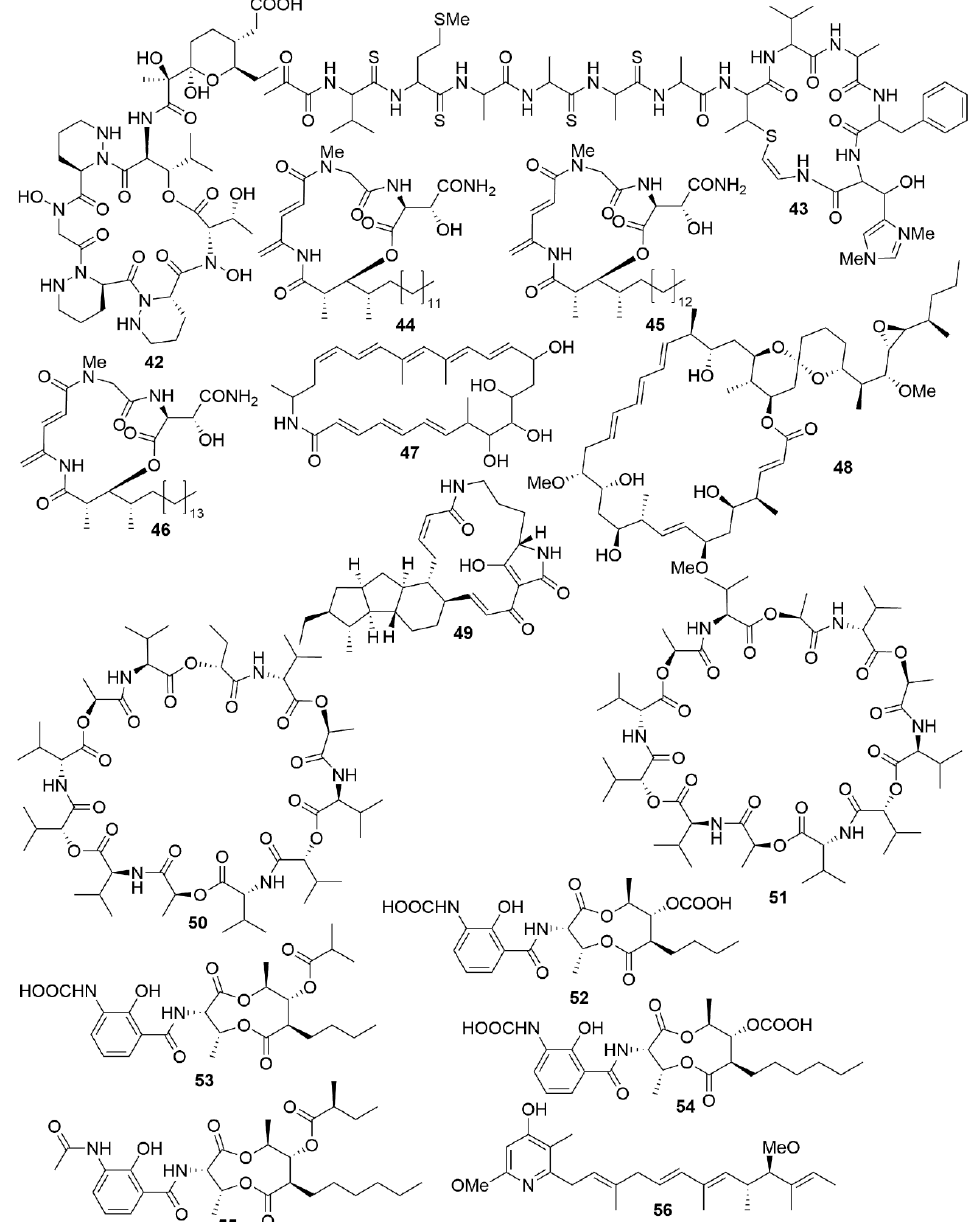
Figure 5. Examples of recently isolated cytotoxic natural products from marine bacteria. Dentigerumycin E ( 42 ), a cyclic hexapeptide isolated from S. albogriseolus JB5. Neothioviridamide ( 43 ), a cyclic peptide from Streptomyces sp. MSB090213SC12. Rakicidin G ( 44 ), Rakicidin H ( 45 ) and Rakicidin I ( 46 ) are cyclic depsipeptides isolated from M. chalcea FIM 02–523. FW05328-1 ( 47 ), a polyene macrolactam isolated from Micromonospora sp FIM05328. Neaumycin B ( 48 ), a macrolide from Micromonospora sp. CNY-010. Pactamide A ( 49 ), a polyketide isolated from S. pactum SCSIO 02999. Streptodepsipeptide P11A ( 50 ) and Streptodepsipeptide P11B ( 51 ) are cyclodepsipeptides from Streptomyces sp. P11-23B. Antimycin E ( 52 ), Antimycin F ( 53 ), Antimycin G ( 54 ) and Antimycin H ( 55 ) are alkaloids isolated from Streptomyces sp. THS-55. Piericidin F ( 56 ) is an alkaloid isolated Streptomyces sp. CHQ-64.